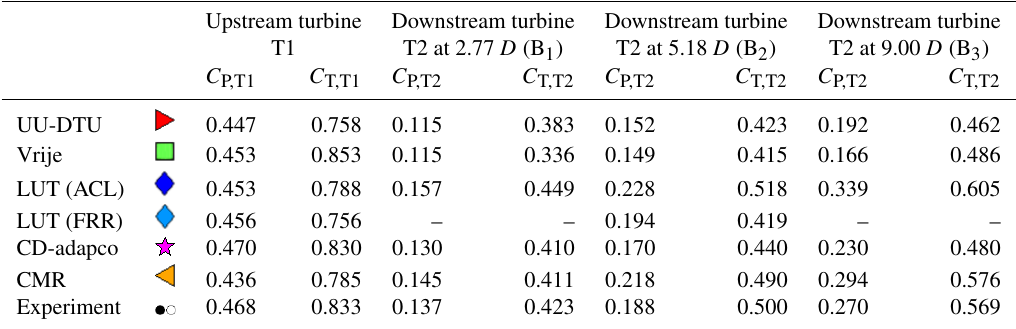
Table 5. Numerical values of power coefficient C P and thrust coefficient C T for test cases B 1 , B 2 and B 3 . The downstream turbine T2 is positioned at 2.77 D (B 1 ), 5.18 D (B 2 ) and 9.00 D (B 3 ) downstream of T1. T1 is operated at λ T1 = 6.0 and T2 is operated at λ T1 = 4.5, referring to the reference velocity U ref = 11.5ms − 1 .